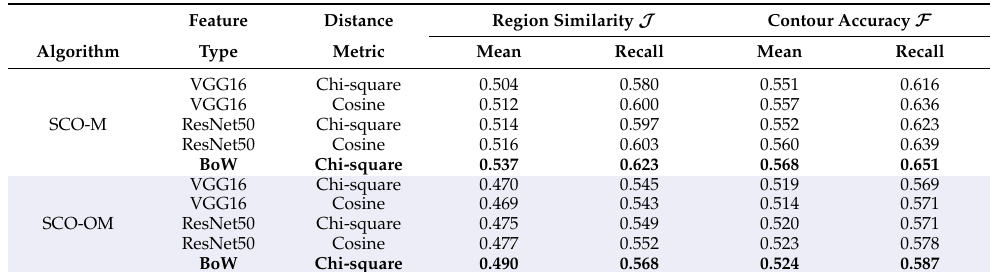
Table 1 lists the J and F performances according to the refinement methods on DAVIS2016. The segmentation refinement can be performed using two methods: (1)